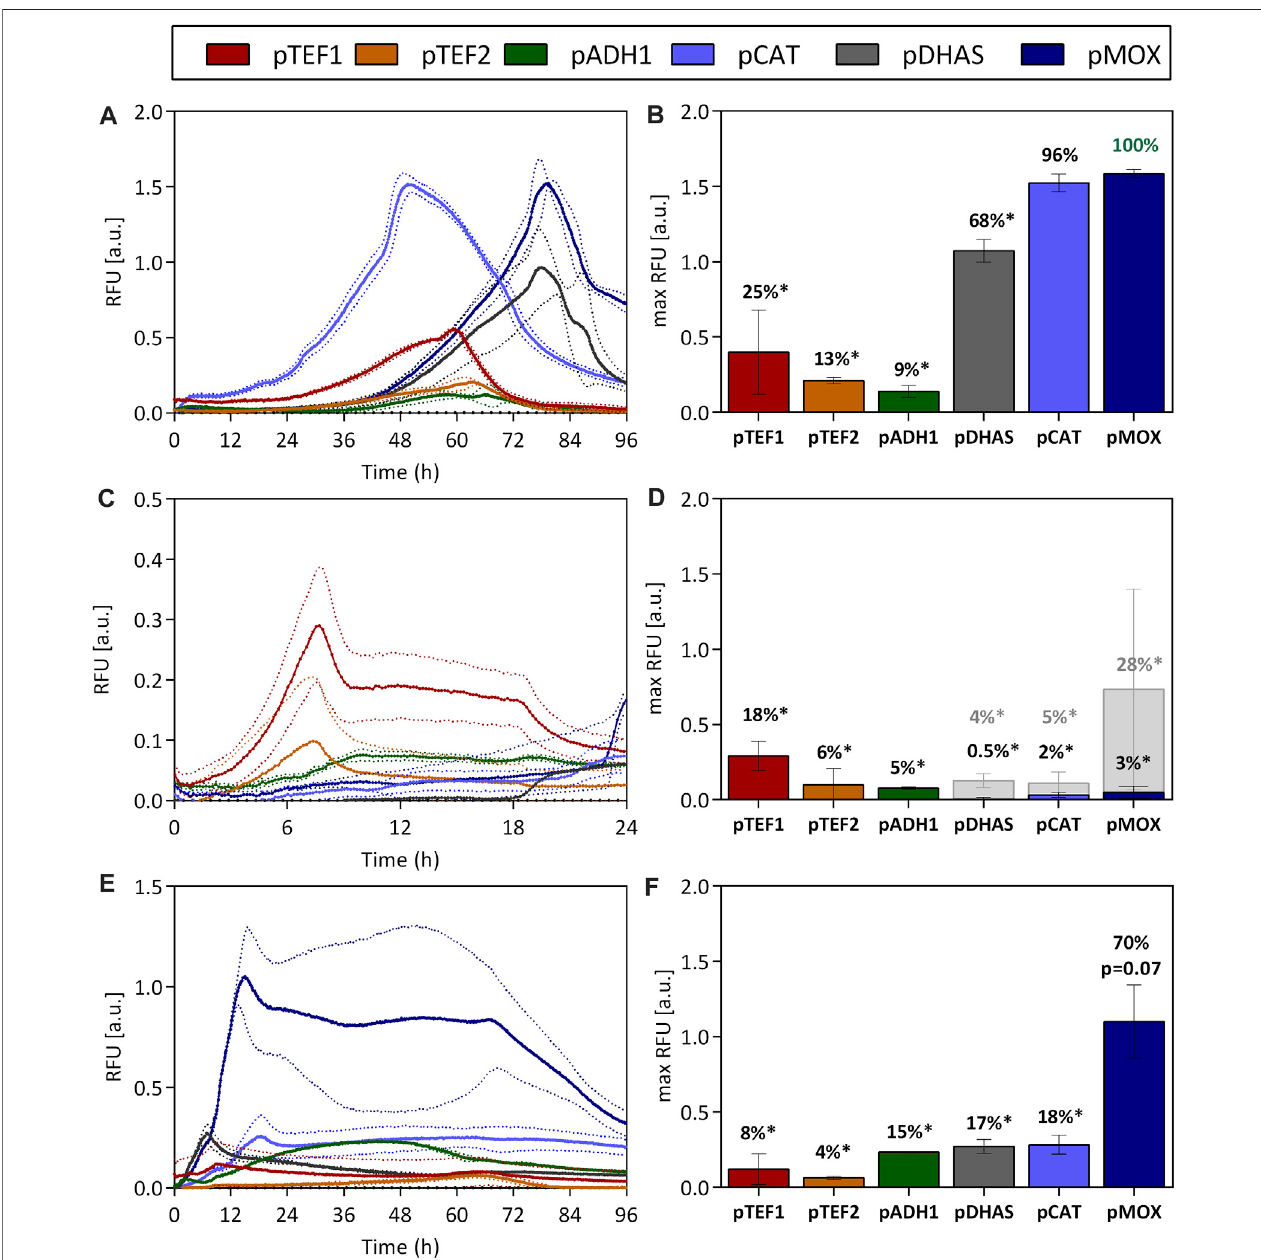
FIGURE 1 | Promoter activities of O. polymorphas ’ native promoters when utilizing methanol (A,B) , glucose (C,D) , and glycerol (E,F) as carbon sources. The in fl uence of O. polymorpha ’ s promoters on gene expression was evaluated by using them to express the reporter gene ubiM-GFP. The GFP gene was put under the control of native promoters from O. polymorpha . The two constitutive promoters pTEF1 and pTEF2, pADH1, and promoters involved in methanol metabolism pDHAS, pCAT,andpMOXarecharacterized.TheGFP ’ s fl uorescencewasnormalizedtothebiomassdensity(expressedasRFU)andmeasuredoverthetime-courseofthe cultivation in48-wellplates.The fl uorescence andgrowthdynamicsduringthe cultivation areindicatedin (A,C,E) while maximum fl uorescencesignalsand percentages correlated to the highest fl uorescence maximum [pMOX 100% in (B) ] are shown in (B,D,F) . Statistical signi fi cance (indicated with * when p < 0.05) was tested with an unpaired t -test between the max RFU of the various promoters and the highest max RFU of the dataset [pMOX 100% in green in (B) ] see Supplementary Table S5 . Dotted lines (A,C,E) and error bars (B,D,F) represent the standard deviation from three biological replicates. Light grey bars indicated in (D) represent maximum RFU after glucose